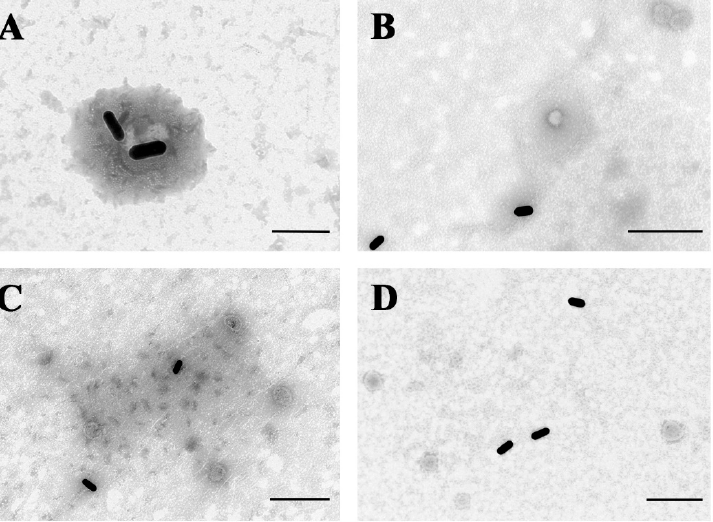
Figure 5. Validation of the specificity of GNR probes based on TEM images. ( A ) GNR probes bound PEDV. ( B ) GNR probes mixed with PRRSV. ( C ) GNR probes mixed with H9N2. ( D ) GNR probes mixed with NDV. Scale bar: 200 nm ( A ) and 500 nm ( B – D ).